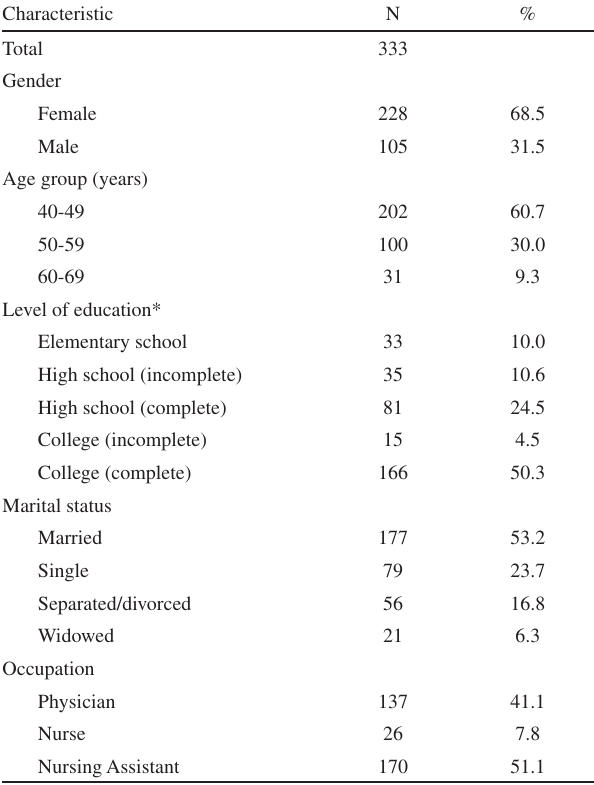
Table 1 - Distribution of health care workers according to so- ciodemographic characteristics, Sao Paulo, Brazil, 2001-2003